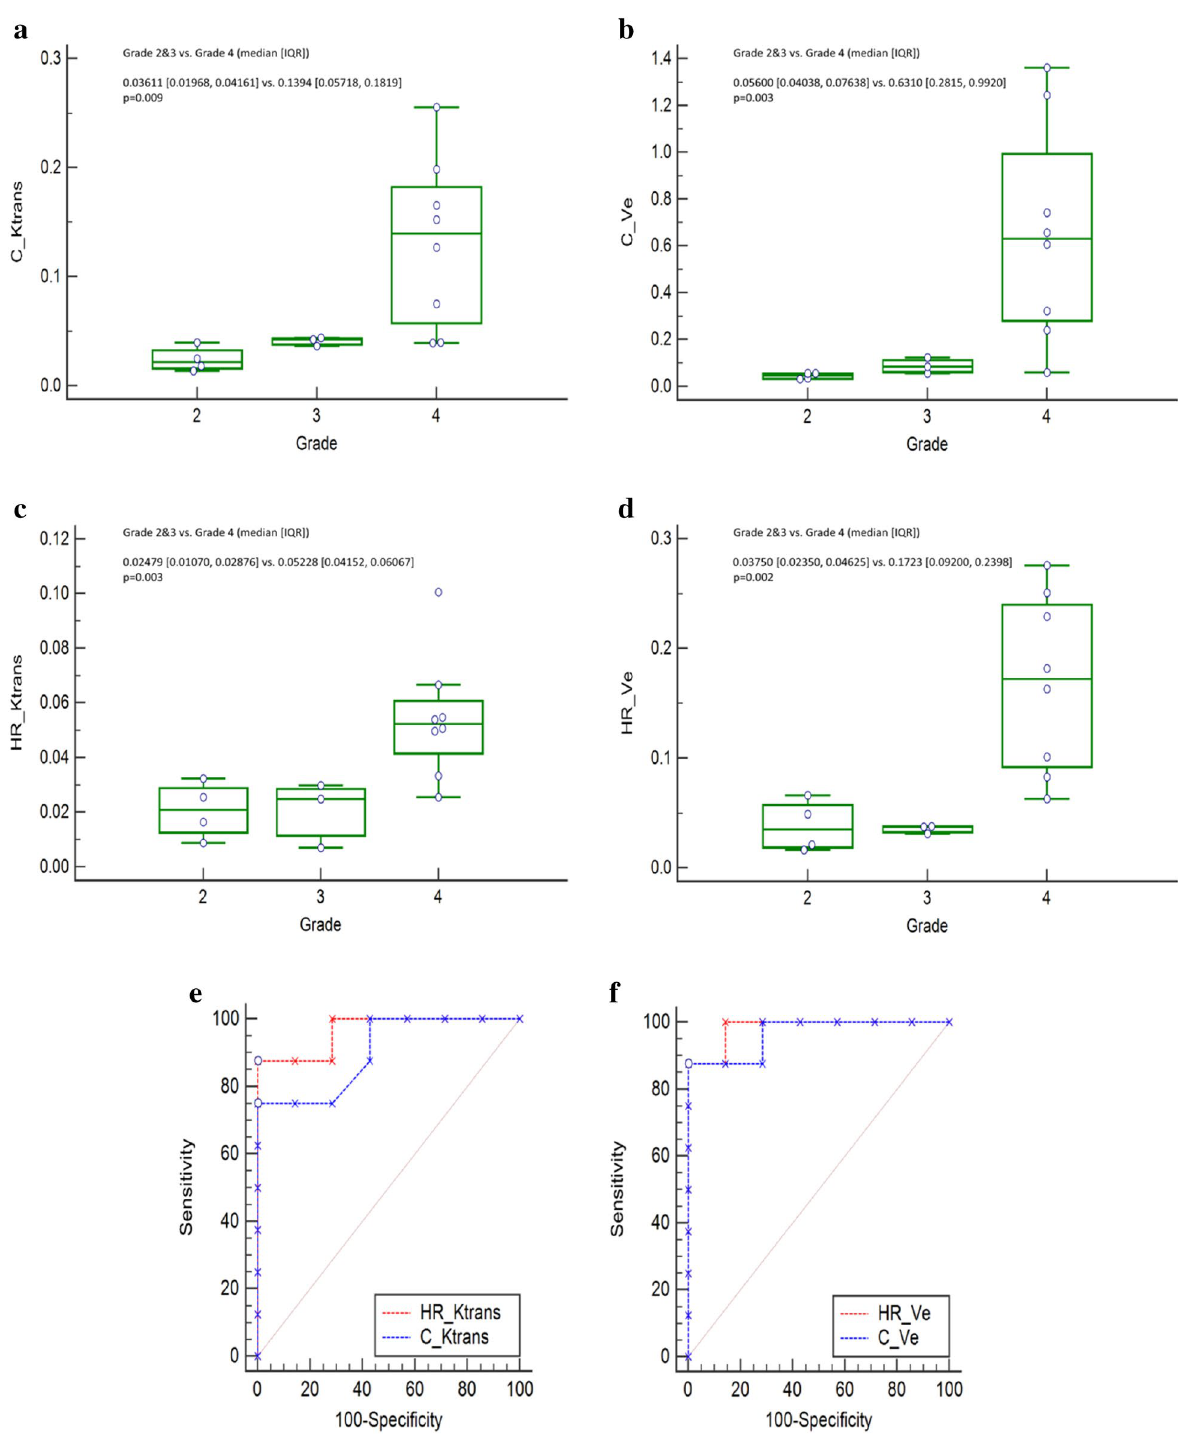
Figure 2. DCE MR parameters as differentiators of WHO tumor grades. ( a ) 95th percentile K trans and ( b ) 95th percentile V e according to tumor grades (grade 4 vs. grade 2 and 3) using C-DCE MR imaging, ( c ) 95th percentile K trans and ( d ) 95th percentile V e according to tumor grades (grade 4 vs. grade 2 and 3) using HR-DCE MR imaging, ( e ) ROC curves derived from K trans and ( f ) ROC curves derived from V e for differentiators of tumor